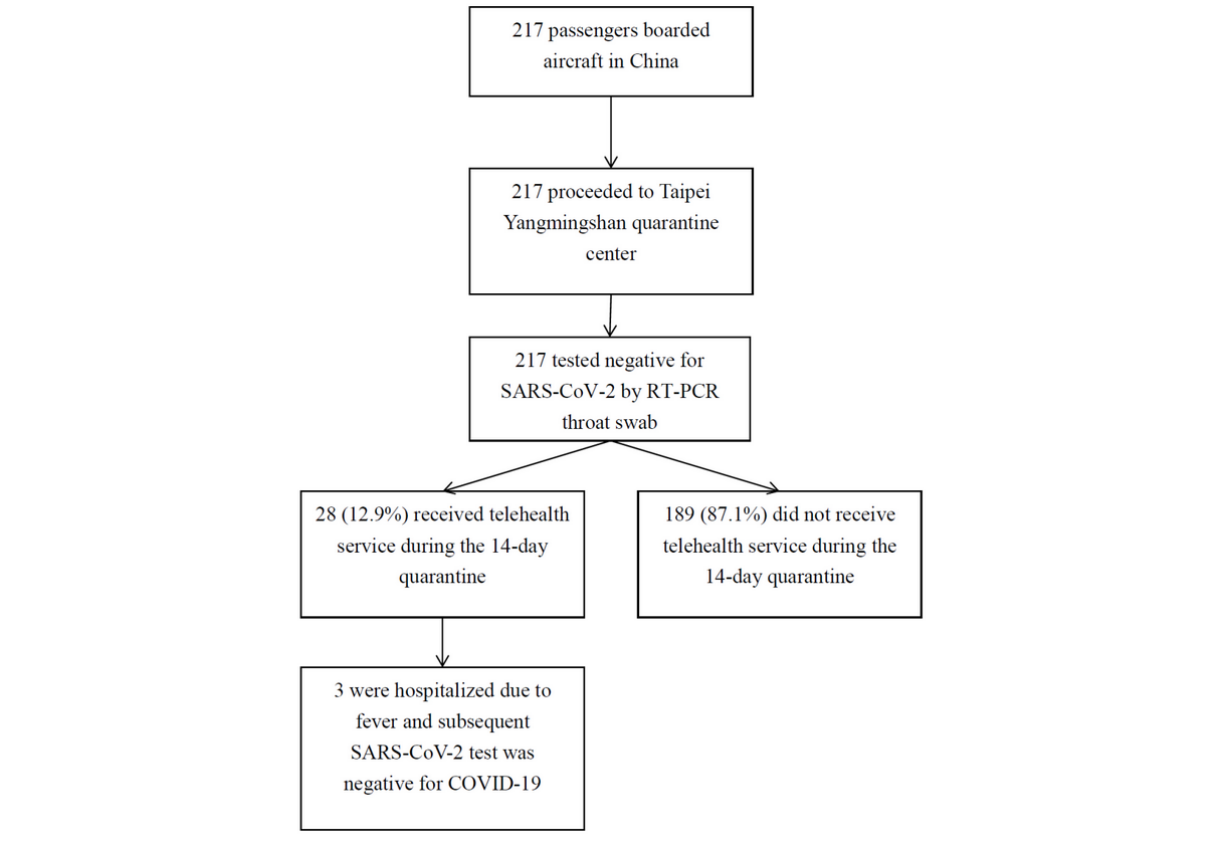
Figure 1. The process of follow-up in Taiwanese travelers quarantined at the Yangmingshan centralized quarantine center. RT-PCR: reverse transcriptase–polymerase chain